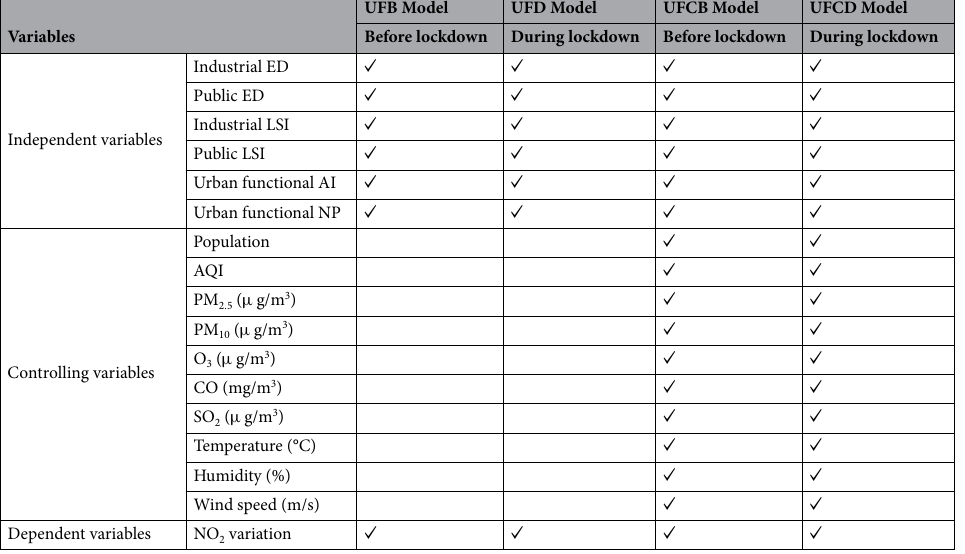
Table 3. Independent and dependent variables for